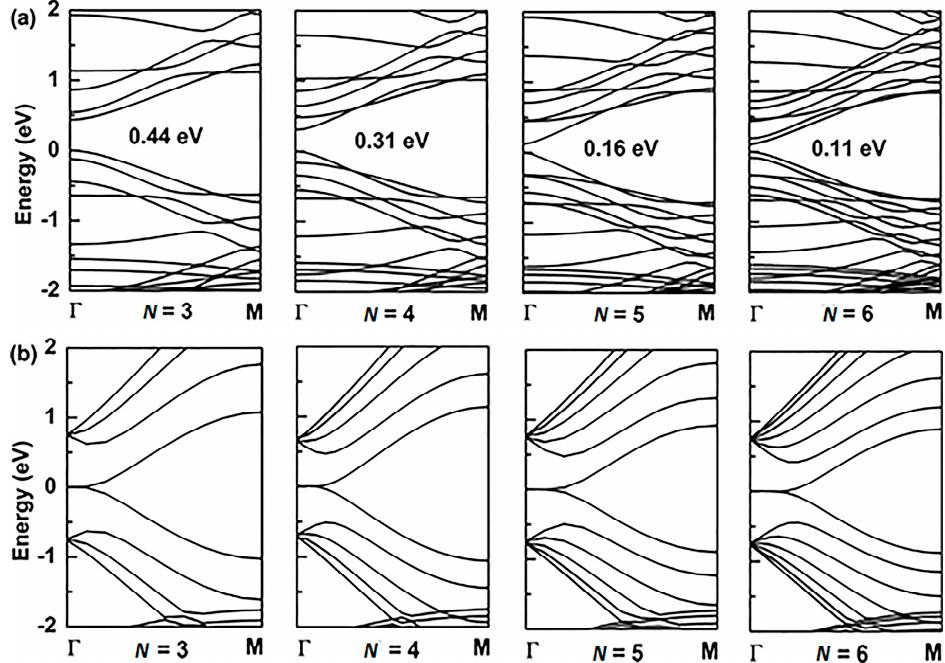
Figure 5. The band structure of armchair-edged β -graphyne nanoribbons with ( a ) N = 3 to 6, and zigzag-edged β -graphyne nanoribbons with ( b ) N = 3 to 5. The Fermi level is set to zero.